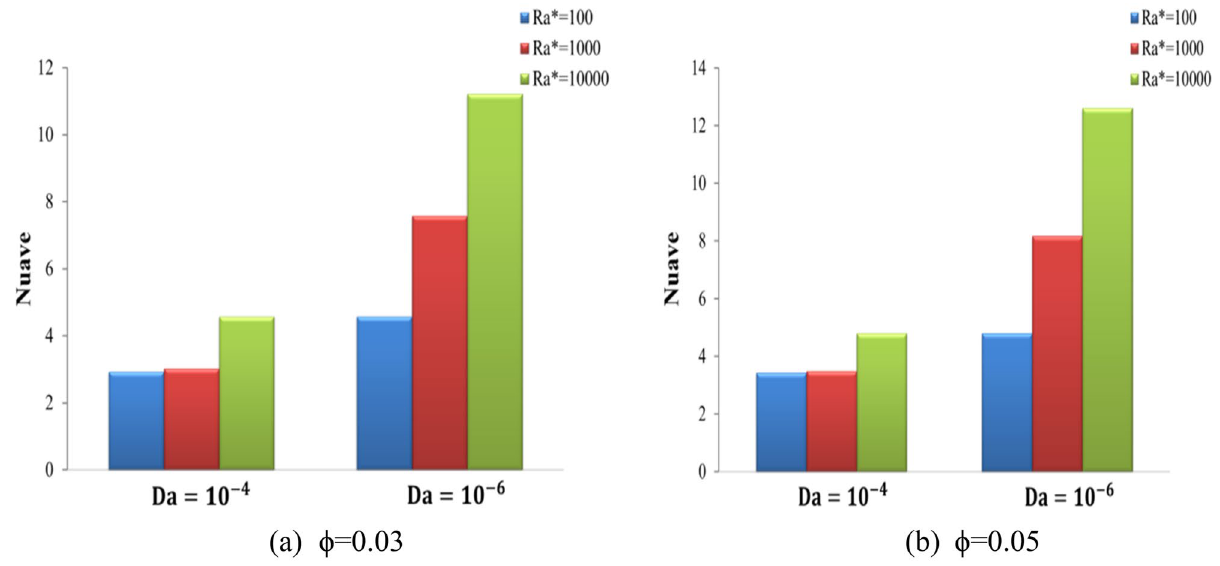
Figure 14. Variation of average Nusselt number (Nu ave ) on the wavy wall for different Ra* and Da at N = 1, A = 0.1, and (a) ϕ = 0.03, (b) ϕ =